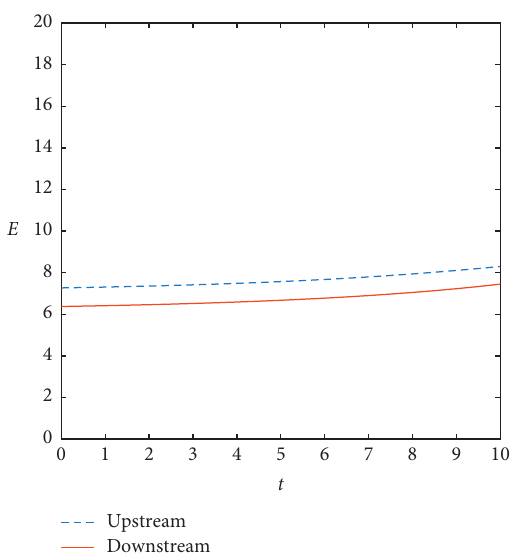
Figure 2: Optimal trajectory of pollution emission under coop- eration when T � 10.